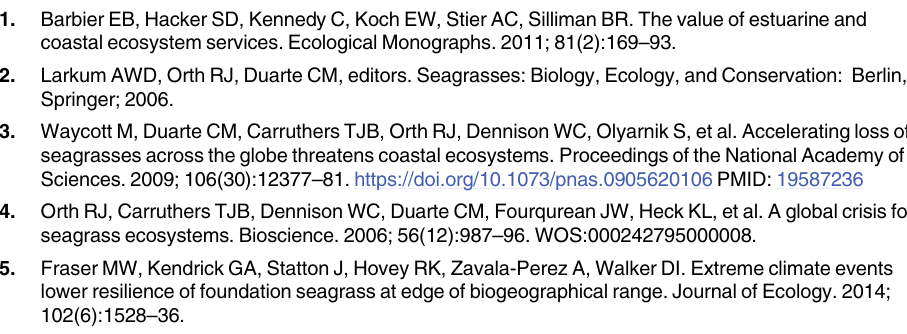
S1 Fig. Illustration of the Batcheler-Corrected Point Distance monitoring